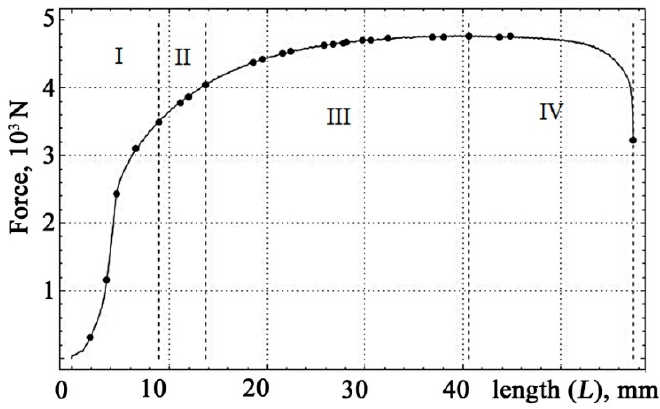
Figure 5. The occurrence moments of vibration signals.